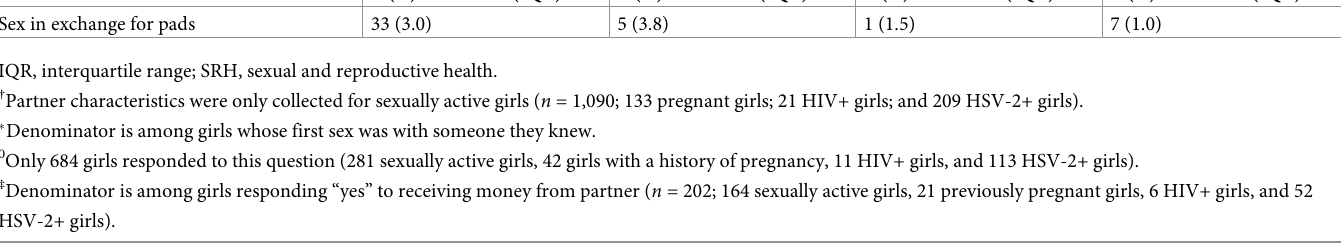
As shown in Table 3, girls reporting sexual activity were older (aRR: 1.17 per additional year of age; CI 1.14 to 1.20, p < 0.001), had higher BMI, with 32.6% classified as overweight (aRR: 1.14; CI 1.02 to 1.28, p = 0.016 relative to girls with normal BMI), and were more likely to report their period stopped them from engaging in daily tasks (aRR: 1.14; CI 1.01 to 1.27, p = 0.032 post-adjustment for all 10 individual characteristics retained in the model). Harass- ment for sex both in school (aRR: 1.23; CI 1.09 to 1.38, p = 0.001) and out of school (aRR: 1.77;